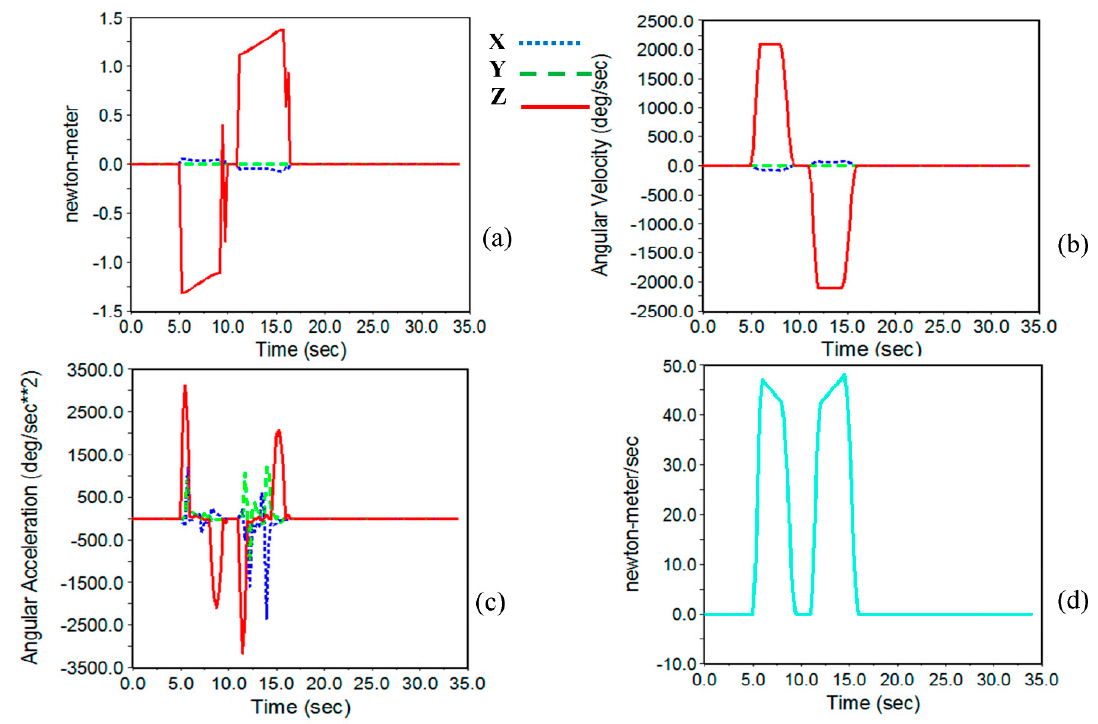
Figure 18. Results of ADAMS software simulation to determine the motor characteristics of the belly-cutting subset (seven fish per minute). In this figure, ( a – d ) are torque, angular velocity, angular acceleration, and required power respectively.